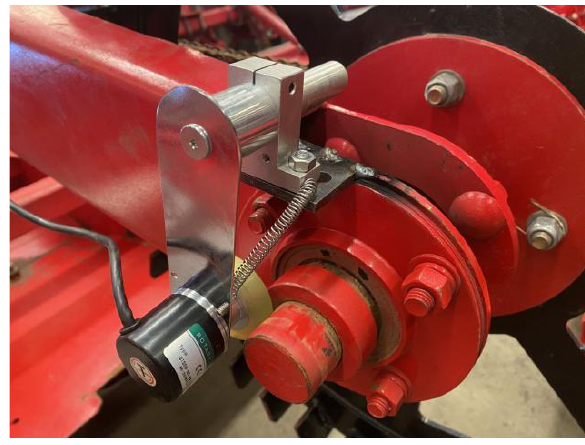
Figure 3. Speed sensor installation diagram.